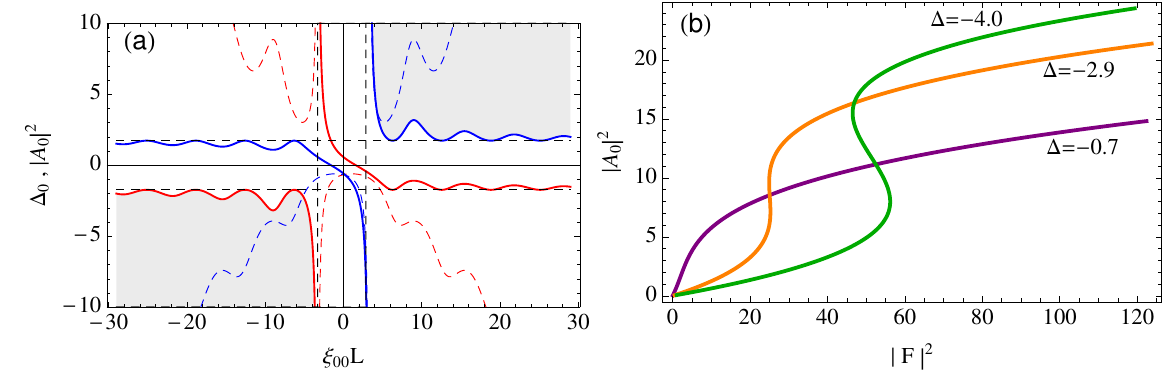
Figure 11: (a) Stability diagram of stationary solutions of Eq. (9) as a function of the detuning ∆ and the matching parameter ξ 00 L , assum- ing g 0 = 1 and 𝛾 0 = 1 . Solid lines represent the critical detunings, ∆ − (red) and ∆ + (blue), while the dashed curves are the corresponding intracavity powers x ± , plotted against the matching parameter ξ 00 L . Physically allowable solution requires x ± > 0 , thus bistability occurs for | ξ 00 L | (cid:38) 3.29 (black vertical dashed lines). The shaded regions identify parameters values for which bistability occurs. The horizontal √ 3 , which is the critical detuning when ξ 00 L is an integer multiple of 2 π and there is no nonlinear loss dashed lines correspond to ∆ 0 = ± due to second-harmonic generation, thus the nonlinear cavity acts as a purely dispersive Kerr cavity. (b) Intracavity power | A 0 | 2 as a func- tion of injected power | F | 2 , for ξ 00 L = 10 and ∆ = −4.0 , −2.9 , and −0.7 , showing the transition from single-valued solution to